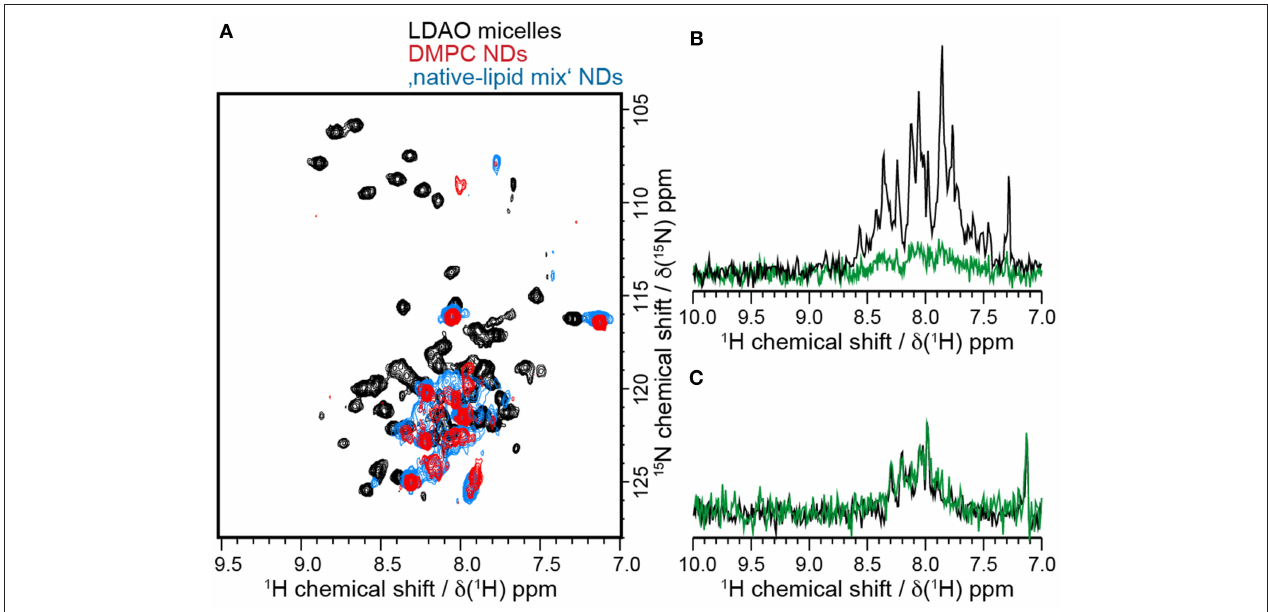
FIGURE 6 | Barttin has different properties in LDAO and NDs. (A) [ 15 N- 1 H]-HSQC spectra of 15 N-labeled barttin in LDAO micelles (black), DMPC NDs (red) and “native-like lipid mix” NDs (blue). (B) 15 N-filtered 1D 1 H NMR spectra of 2 H- 13 C- 15 N-labeled barttin in LDAO micelles at the beginning of the NMR measurements (black) and after 14 days (green). (C) 15 N-filtered 1D 1 H NMR spectra of 15 N-labeled barttin in DMPC NDs at beginning of NMR measurements (black) and after 18 days